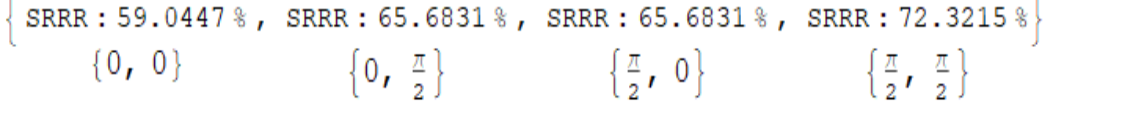
Figure 3. Solar Radiation Reception Rate for m = 2 and n = 1 at the equinox in the region of Makkah, Saudi Arabia.